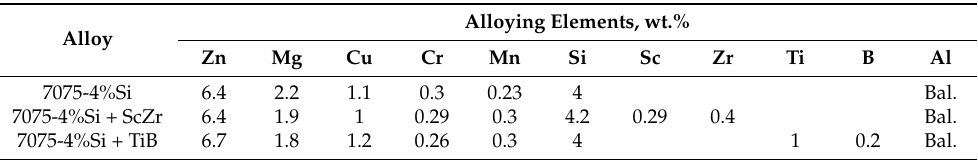
Table 1. Chemical composition of the investigated alloys.